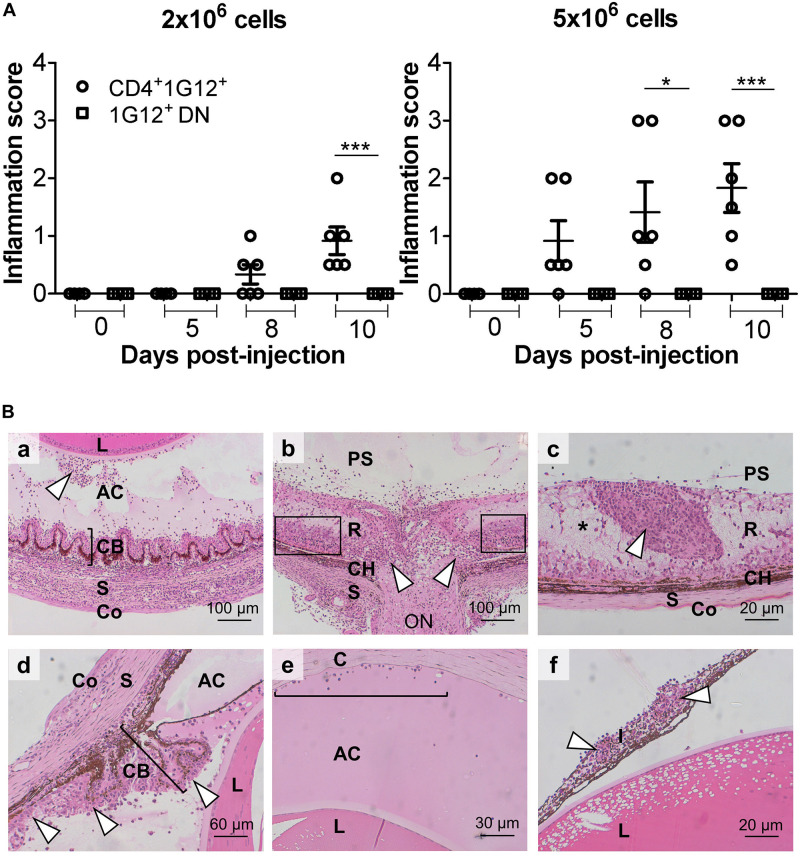
Adoptive transfer of HEL protein-activated 3A9 CD4+ T cells but not DN T cells induces severe EAU in IRBP:HEL sTg mice. (A) Antigen-specific CD4+ T cells and DN T cells were sorted from P50-70 3A9 TCR mice, labeled with CFSE proliferation dye and incubated with HEL protein (1 μM) for 72 h. Fundus images of sTg mice were taken, and retinal appearance clinically scored before adoptive transfer (Tx) at baseline (0; P20), and then at d5 (P25), d8 (P28) and on d10 (P30) after Tx (n = 6/time point). 2 × 106 CD4+ cells induced EAU within 8 days while 5 × 106 CD4+ cells induced severe EAU within 5 days of Tx. Adoptive transfer of DN CD3+ cells did not induce EAU despite being activated by HEL antigen even with doses of 10 × 106 cells (data not shown). Data were analyzed for each time point using one-way ANOVA and Tukey’s Multiple Comparison post hoc Test with *p < 0.05, ***p < 0.001 on a 95% level of confidence. (B) Representative images of heamatoxylin and eosin (H&E) stained sections from adult (P45-P60) sTg IRBP:HEL mouse eyes, 8 days following Tx of HEL-activated CD4+ T cells from 3A9 TCR mice of the same age. Adoptive transfer induced a severe, multifocal panophthalmitis (17) (a) Cyclitis with “plastic” infiltrate in the vitreous and cellular precipitates on posterior lens surface (arrowhead). (b) Central retinal vasculitis and optic nerve destruction with granuloma plus some surrounding intact retinal tissue remaining (boxes). (c) Tertiary lymphoid organ (TLO; arrowhead) surrounded by edematous and necrotic retinal tissue (pale staining region; asterisk) (d) Inflammation of the ciliary body (bracket) (cyclitis) and posterior chamber (arrowheads) with plastic exudate in the anterior chamber. (e) Plastic deposit in the anterior chamber with keratic precipitates adherent to the corneal endothelium (bracket). (f) Massive cell infiltration in iris (iritis) with two granulomas (arrowheads). R, retina; CH, choroid; S, sclera; C, cornea; ON, optic nerve; AC, anterior chamber; L, lens; I, iris; PS, posterior segment; CB, ciliary body; Co, conjunctiva.